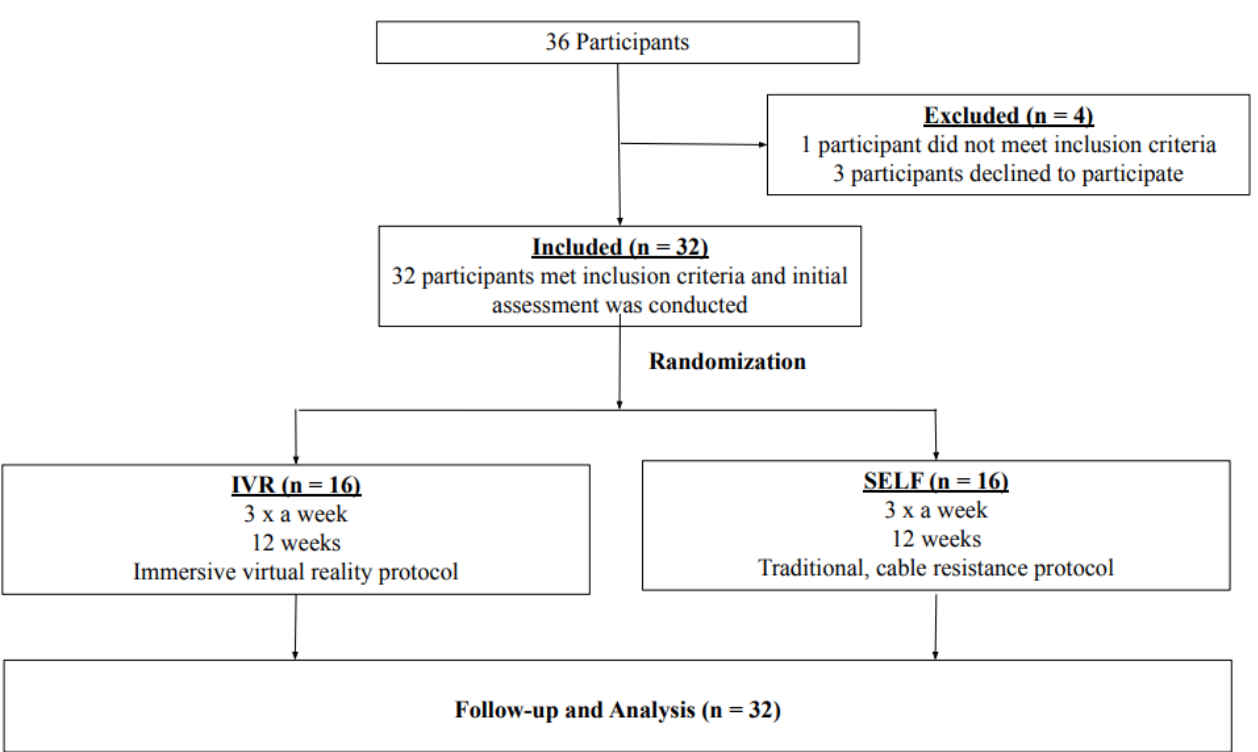
Figure 1. CONSORT diagram showing participant flow through the study. IVR, Intervention; SELF,